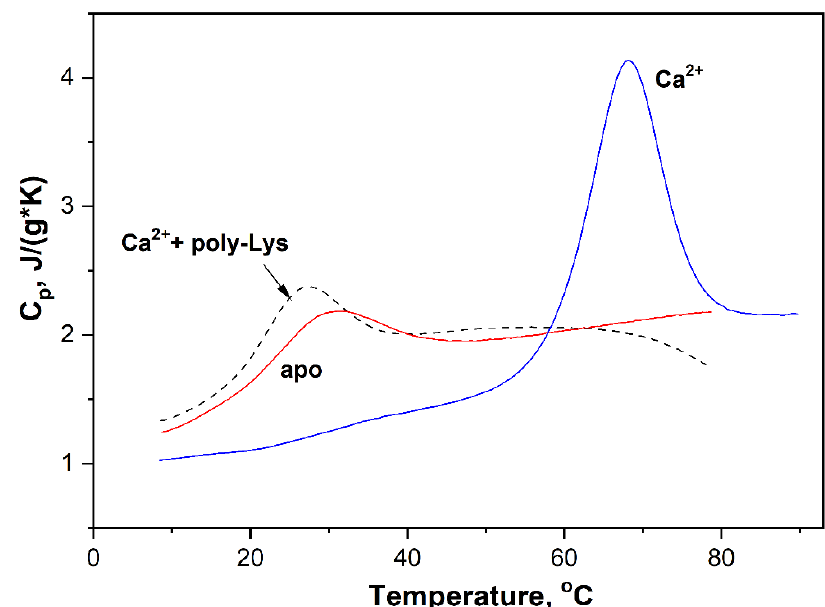
Figure 5. Temperature dependence of specific heat capacity of human α -lactalbumin ( α -LA) in the complex with poly-L-Lys ( n = 119), estimated from scanning microcalorimetry data (pH 7.8, 10 mM HEPES-KOH). Concentration of calcium ions was controlled by addition of either 1 mM CaCl 2 (Ca 2 + ) or 1 mM EDTA (apo). Concentration of α -LA was 1 mg / mL. Poly-L-Lys was added in equimolar concentration.